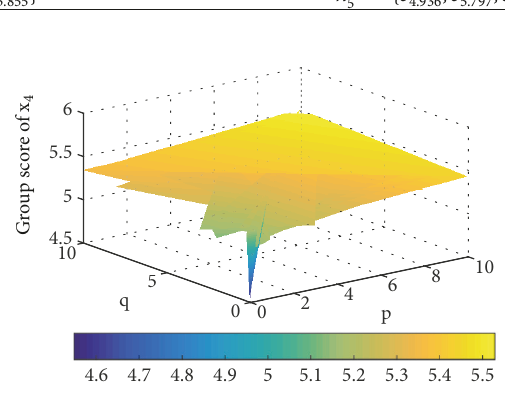
Figure 5: Group scores of the 𝑥 4 .